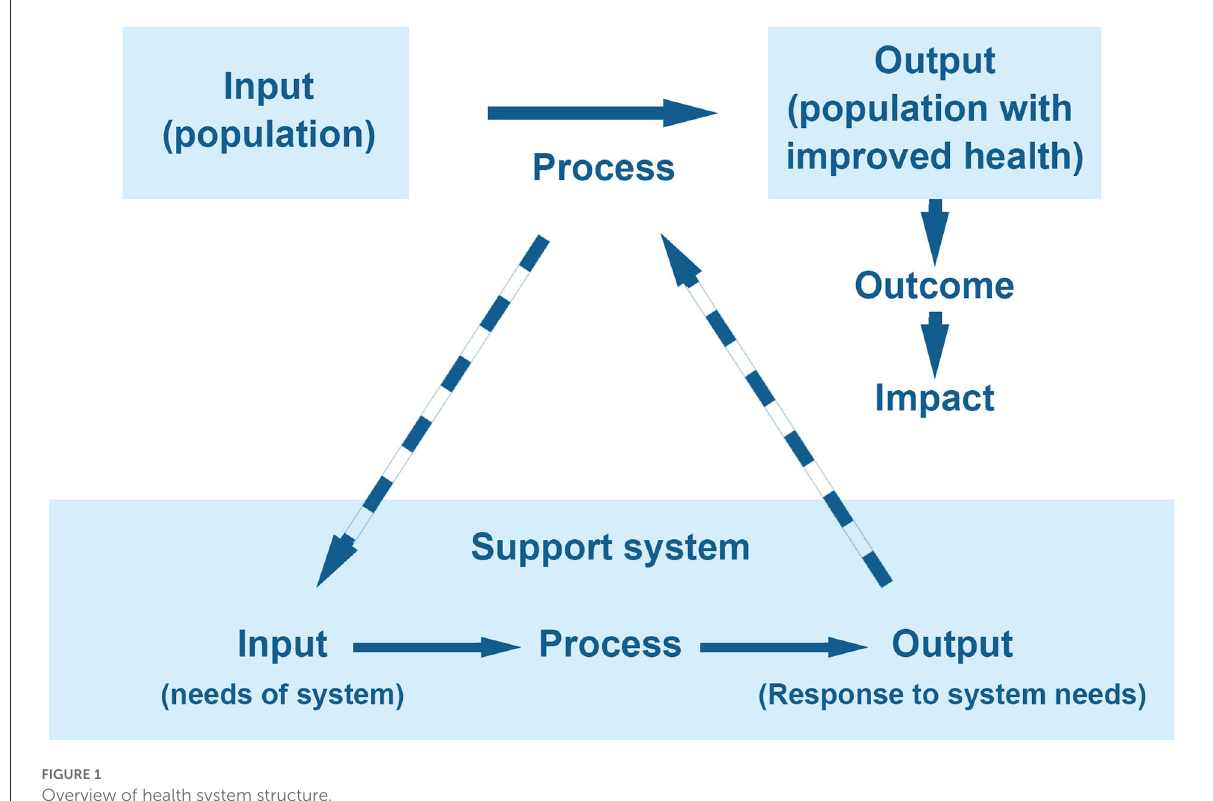
FIGURE1 Overview of health system structure.